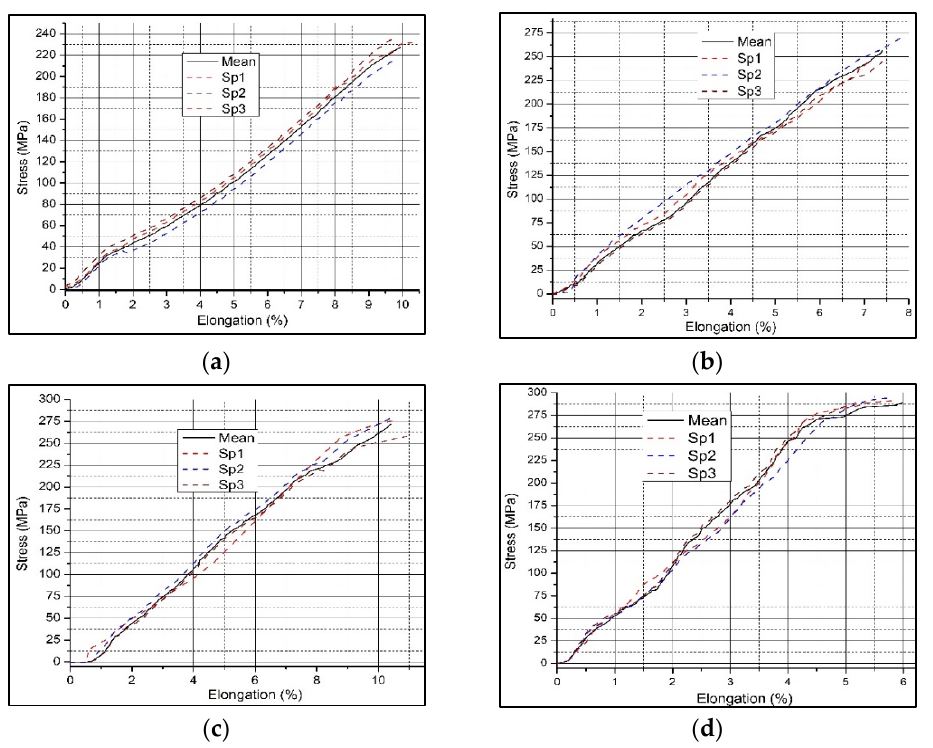
Figure 9. Stress–Strain relation of: ( a ) AA7075 (base alloy, sample 1), ( b ) AA7075-5wt %SiC (MMC, sample 2), ( c ) AA7075-5wt %SiC-3wt %RHA (s-HMMC, sample 3) and ( d ) AA7075-5wt %SiC-3wt %RHA-1wt %CES (n-HMMC, sample 4).